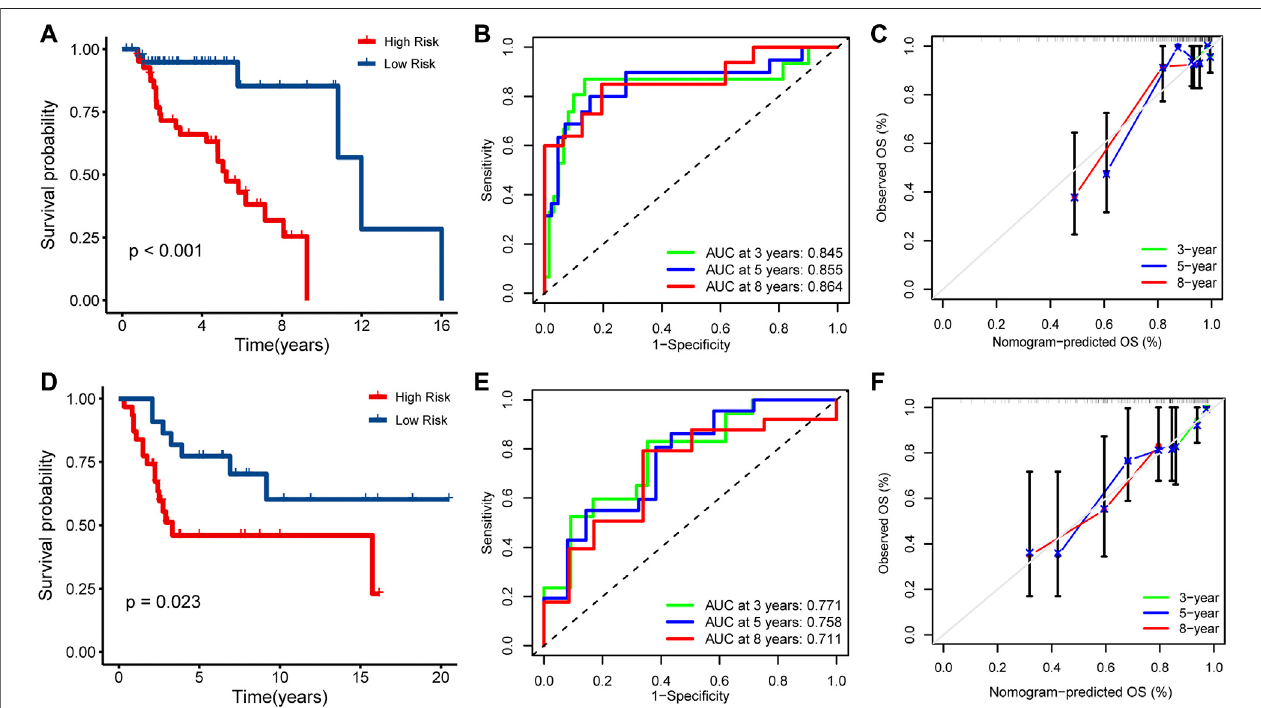
FIGURE3| PrognosticanalysisofIRPS.Kaplan-MeieranalysisofIRPSinthe (A) TARGETcohortand (D) GSE21257cohort.Time-dependentROCcurvesofIRPS in the (B) TARGET cohort and (E) GSE21257 cohort at 3-, 5-, and 8-years. Calibration chart analysis suggested a high accuracy of 3-, 5-, and 8-years OS prediction in the (C) TARGET cohort and (F) GSE21257